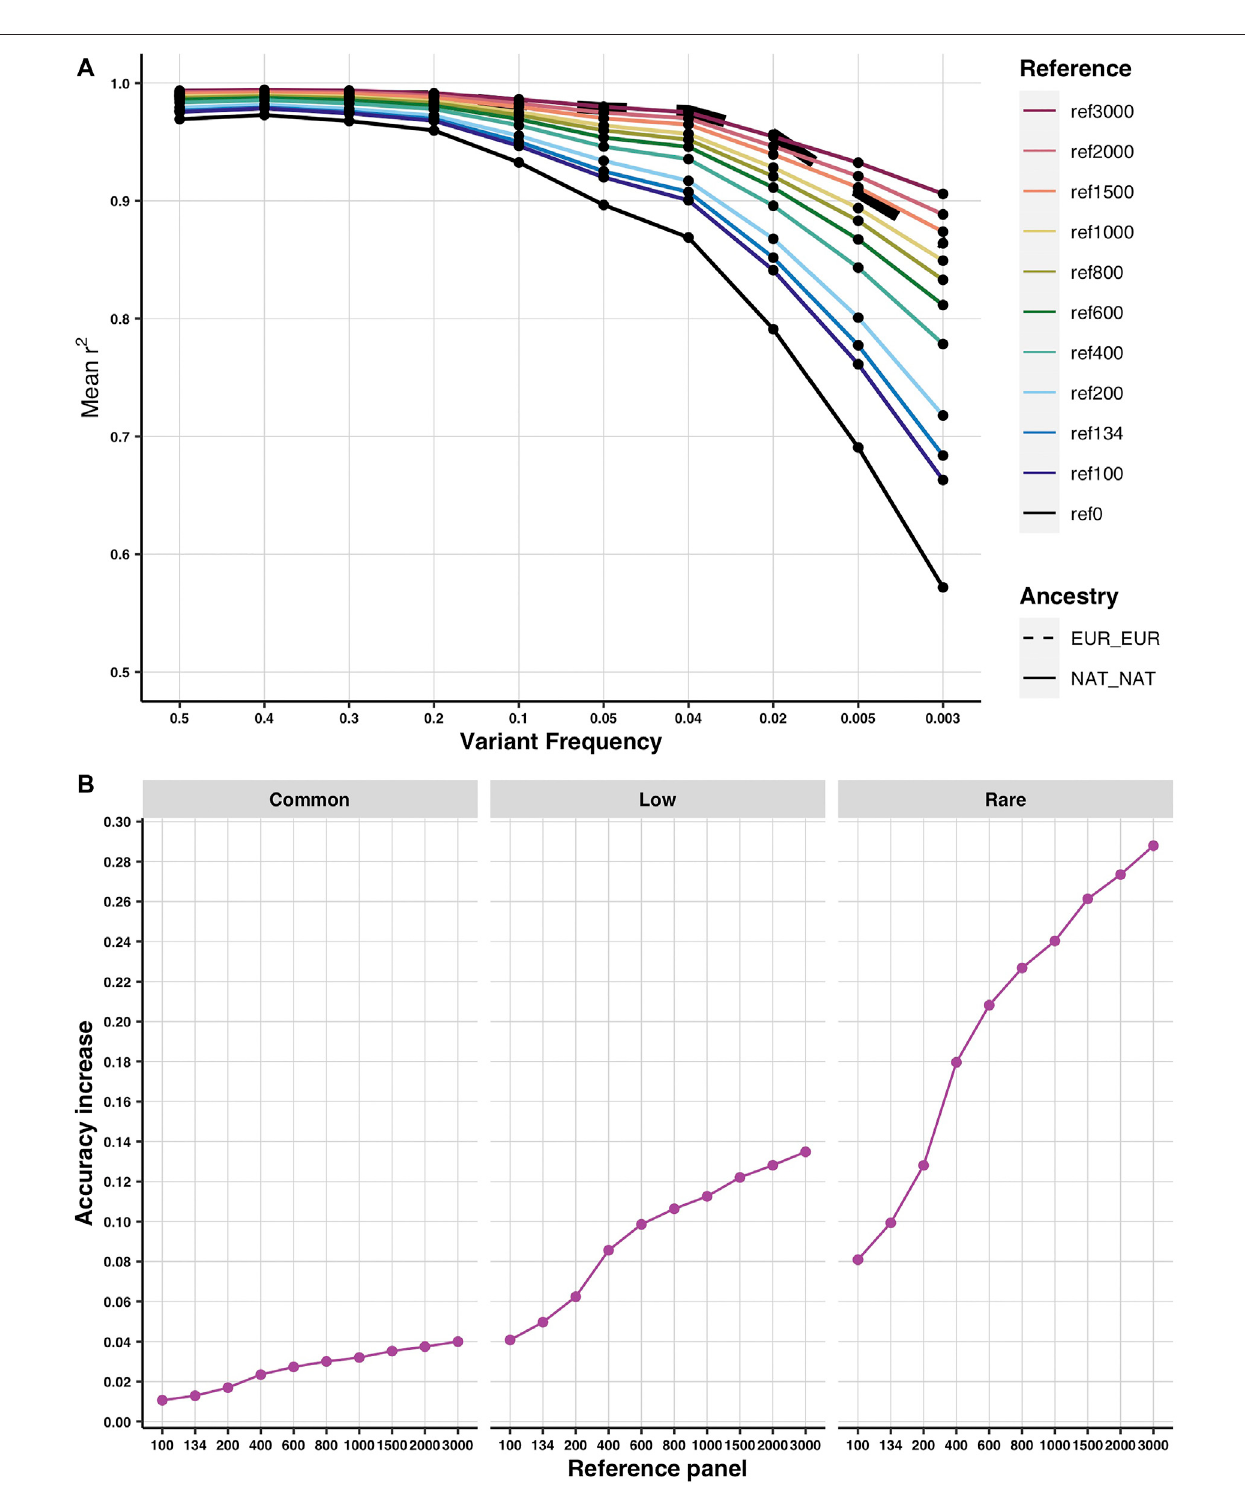
FIGURE 3 | Predicted imputation accuracy according to demographic simulations. (A) Imputation accuracy in the diploid Native American (solid colored lines) and diploid European (thick dashed line) ancestries using different simulated reference panels of incremental sizes. Ref 0 stands for the base reference (as it has 0 additional referencegenomes).Giventheavailable demographic model(Browning etal.,2018),asimulatedAsianpopulation wasused asaproxyfor NativeAmericanancestryfor thepurposeofreproducingathree-wayadmixtureprocesswithsimilarancestryproportionsofAfrican,European,andNativeAmericansourcestothatobservedin admixed Latino populations (see Methods for details). (B) Increase in imputation accuracy from the base reference in the Native American diploid ancestry at increasing sizes of the reference panel by allele frequency [common (0.5 – 0.05), low (0.05 – 0.01), and rare (0.01 – 0.003)].